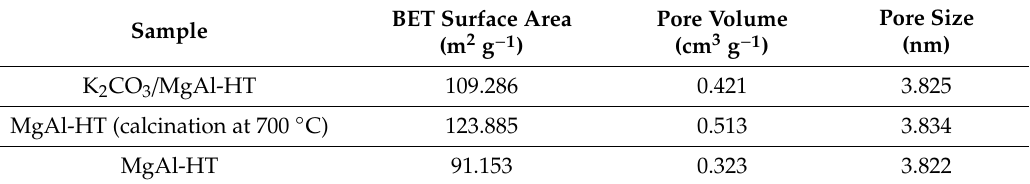
Figure 4. Nitrogen adsorption–desorption isotherms and pore size distribution curve of K + /HT. Table 1. Pore structure properties of the catalysts.